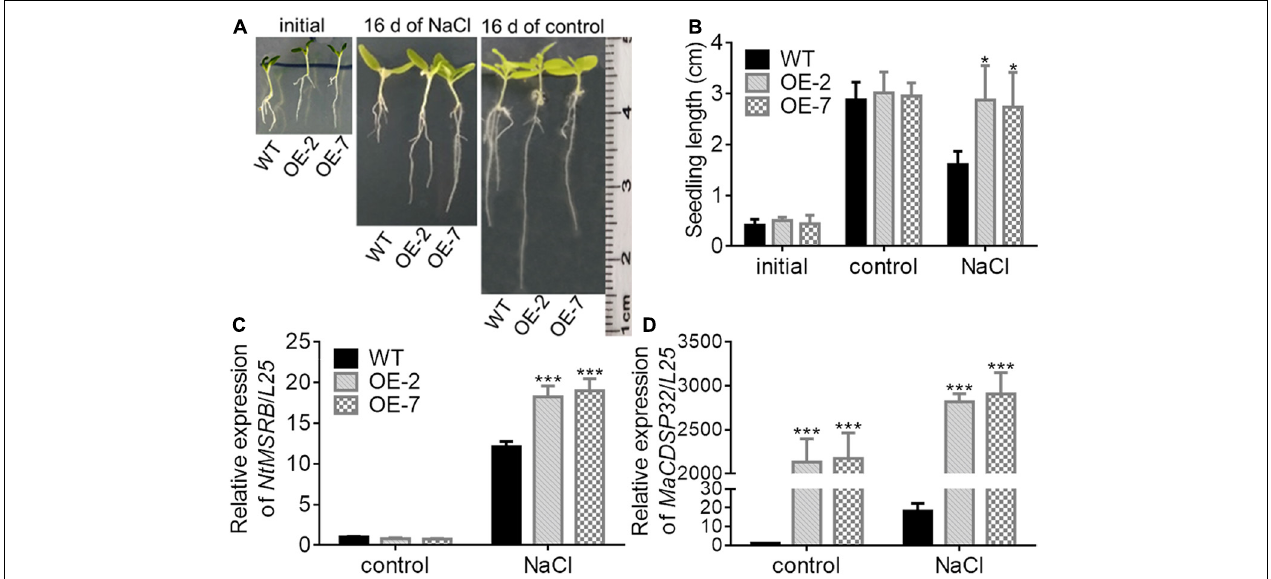
FIGURE 8 | Overexpression of MaCDSP32 enhances the growth of transgenic tobacco seedlings under NaCl stress. (A) Phenotypes of two transgenic lines of tobacco seedlings (OE-2 and OE-7) and of WT tobacco seedlings at transplant (initial), after 16 days of 200 mM NaCl stress and after 16 days under normal conditions. (B) Seedlings lengths of treated tobacco. (C,D) Relative expression of NtMSRB (C) and MaCDSP32 (D) in tobacco seedlings after 16 days of 200 mM NaCl stress. Initial: newly transplanted seedlings, which germinated 9 days after sowing under normal conditions. At least three biological replicates were included. Asterisks indicate significant differences between the transgenic and WT lines ( t -test, * P < 0.05, *** P <